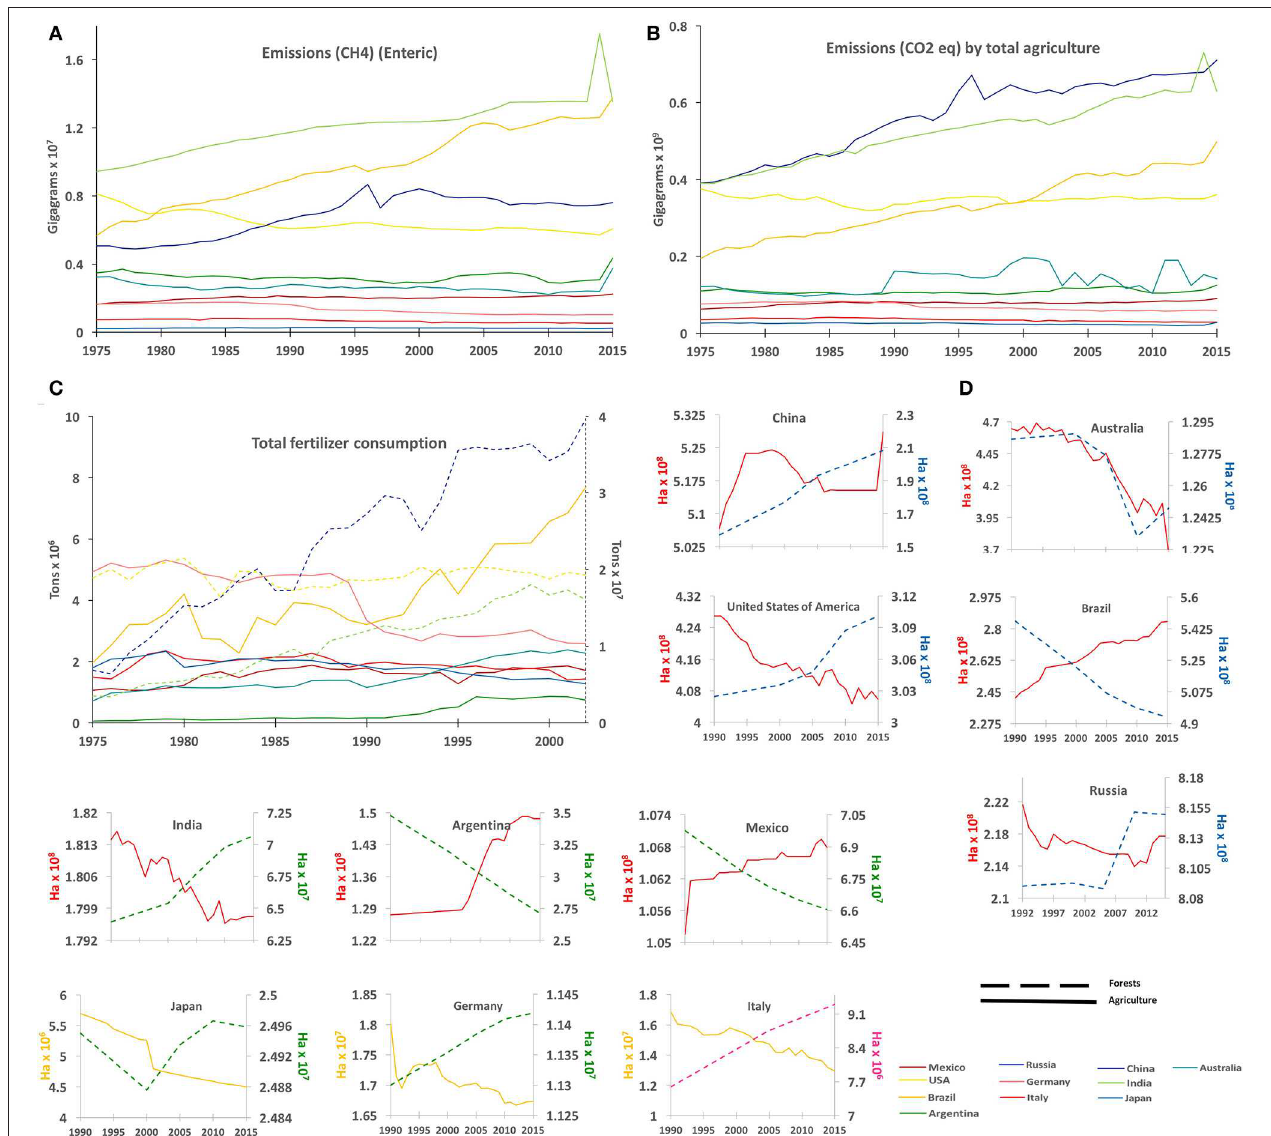
FIGURE 2 | Environmental variable behavior, over 40 years, for of the 11 countries with the highest prevalence of NCD: Greenhouse gas emissions due to agricultural activities: (A) CH 4 and (B) CO 2 ; (C) fertilizer consumption; and (D) Land-use change for each country over 20 years of